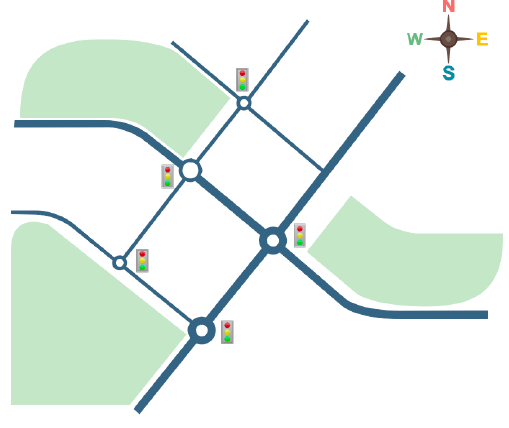
Figure 1. Distribution of intersections in a traffic grid.